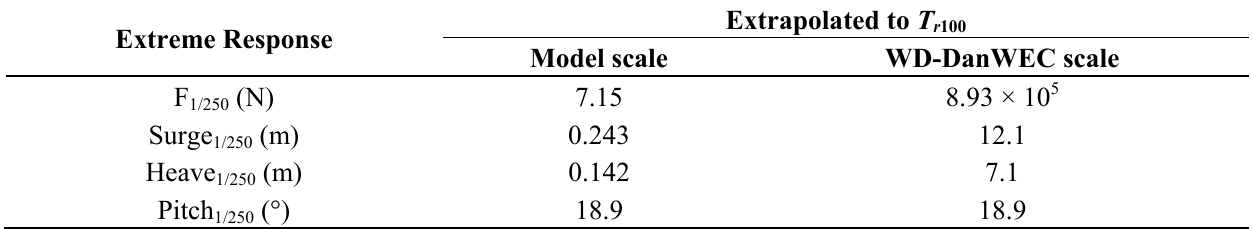
conditions, at model and full r 100